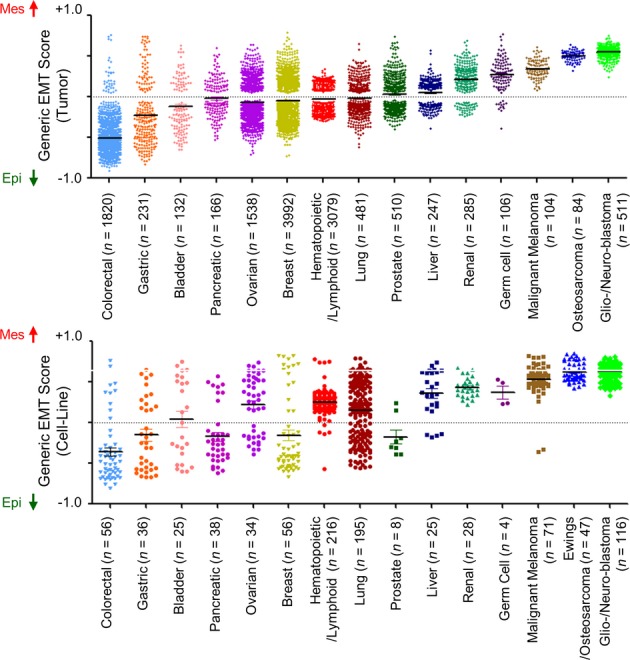
Epithelial-mesenchymal transition (EMT) scores in different cancers typesScatter plot of EMT scores (mean ± SEM;y-axis) of various cancers in clinical samples (upper panel) and cell lines (lower panel) sorted by cancer type and mean EMT score. EMT score nearer to +1.0 is more mesenchymal-like (Mes), whereas EMT score nearer to −1.0 is more epithelial-like (Epi). EMT scores of overlapping cell lines in Cancer Cell Line Encyclopedia (CCLE) (Barretinaet al, 2012) and SANGER/COSMIC (Garnettet al, 2012) collections were averaged.